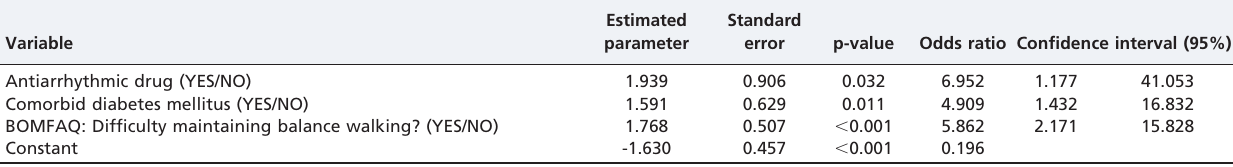
Table 2 - Logistic regression of the independent variables of the risk of falls. Variable